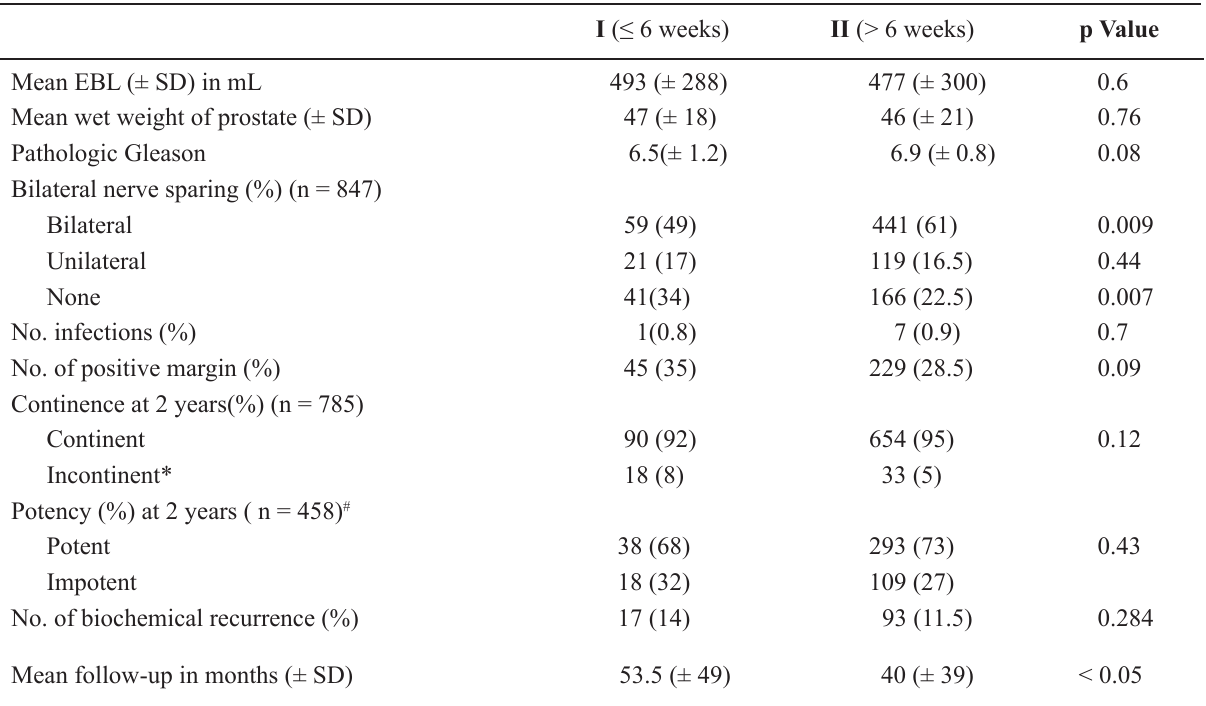
Table 2 – Comparison of surgical, functional and oncologic